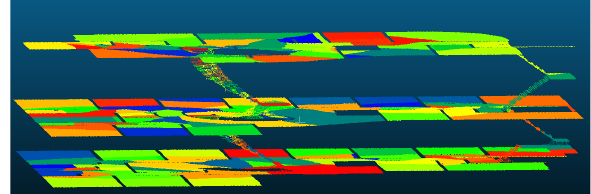
Figure 9. Subdivision of surface skeleton into a Voronoi diagram according to the nearest node in the line skeleton